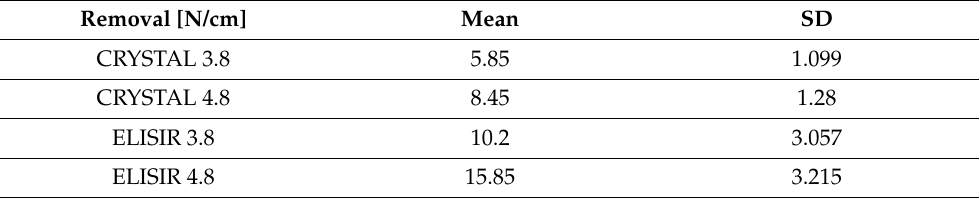
Table 3. Summary of removal torque means of the study groups.